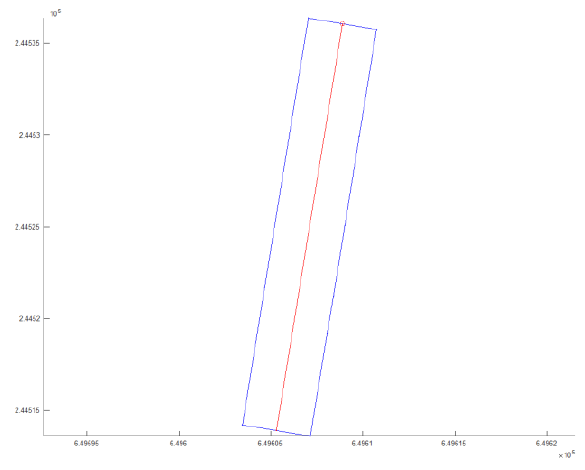
Figure 3. Lane-axis matching Figure 4. Innermost polygon and its right neighbor